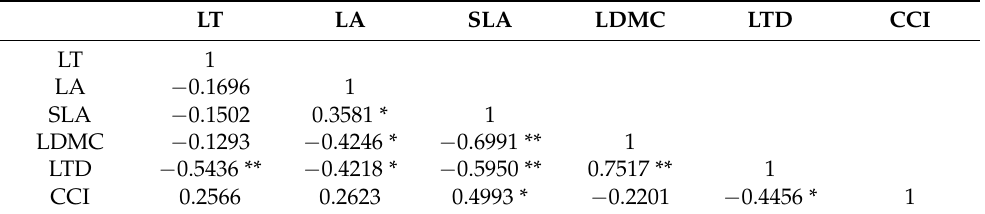
Table 3. Correlation between plant functional traits indicators. * indicates a significant correlation between functional traits at the level of p < 0.05, and ** indicates a significant correlation between functional traits at the level of p < 0.01.